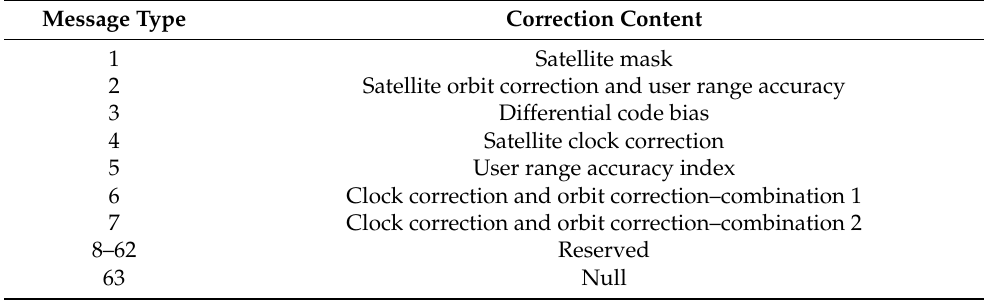
Table 1. The message types and their correction